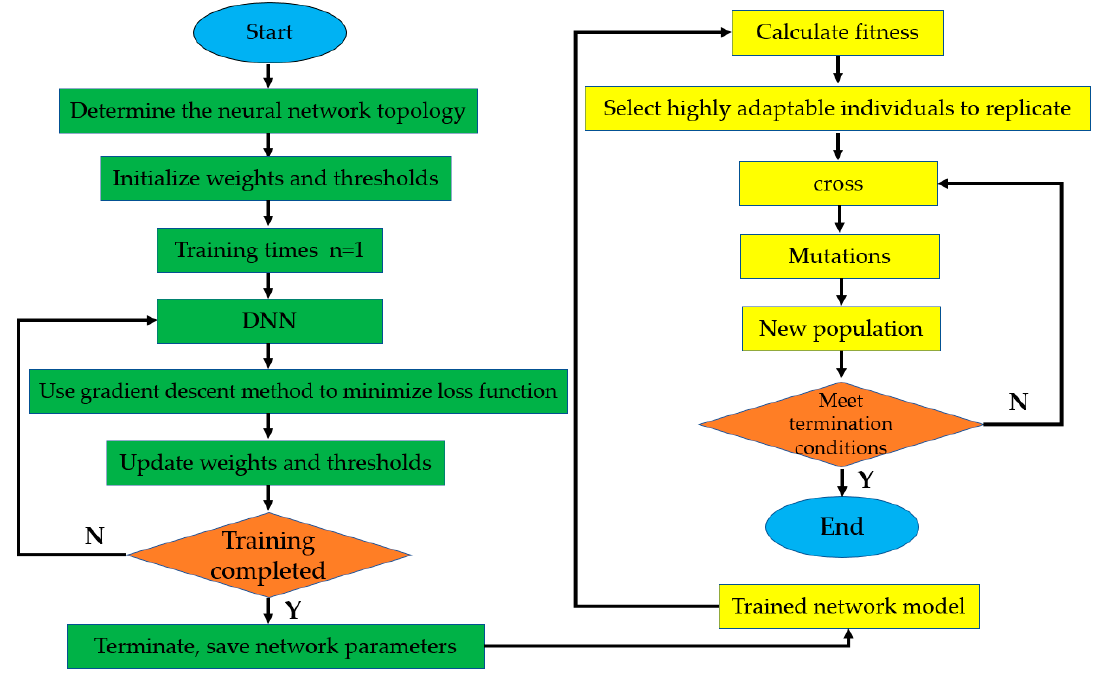
Figure 5. Low-alloy steel composition design model.